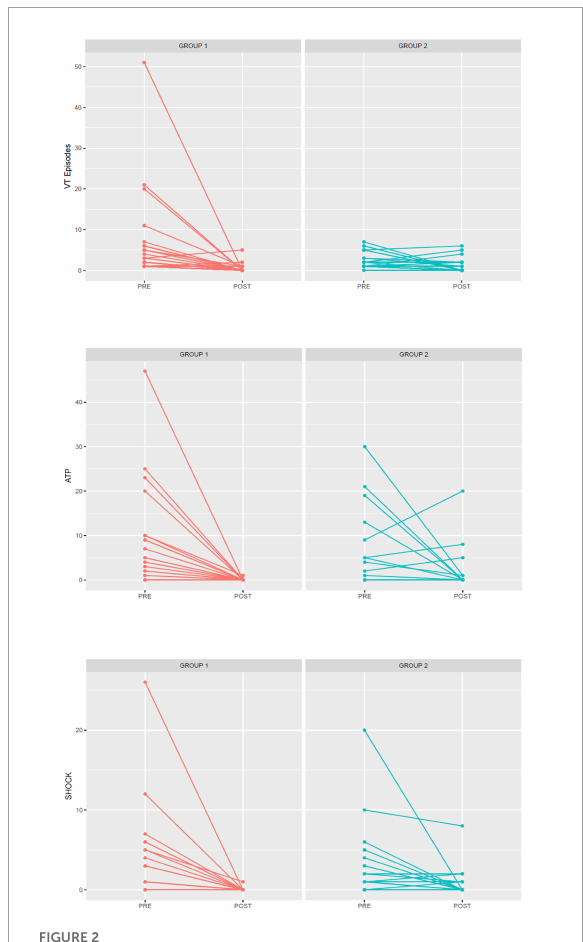
FIGURE2 Differences in arrhythmic burden (VT episodes, ATP, and shocks) between pre- and postablation by group (group 1, extensive HD mapping, red; group 2, scar dechanneling,